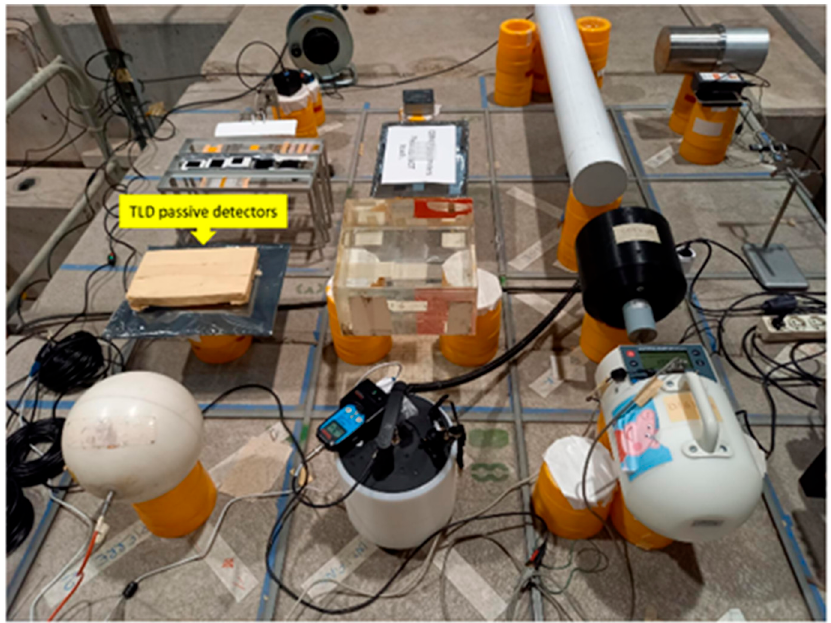
Figure 6. Irradiation set up at CERN ‐ EU High Energy Reference Radiation Field (CERF) facility: the thermoluminescent dosimeters (indicated by a yellow label) were exposed simultaneously with other neutron detectors on the concrete platform.